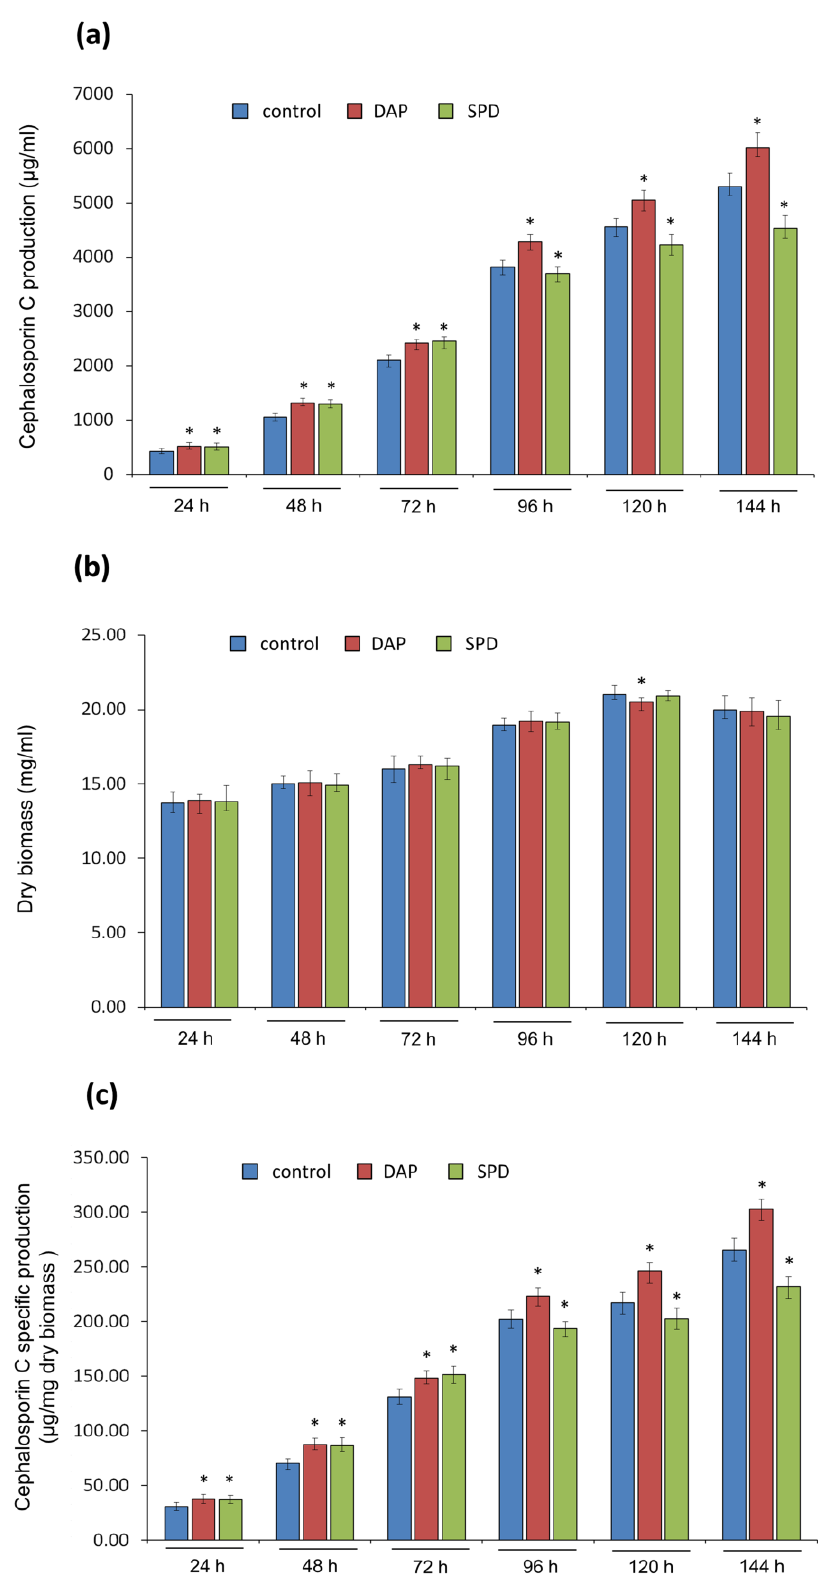
Figure 3. Effect of the addition of 5 mM 1,3-diaminopropane (DAP) or 5 mM spermidine (SPD) on cephalosporin C (CPC) production and growth of A. chrysogenum HY strain during fermentation on synthetic (SN) medium: ( a ) CPC production; ( b ) dry weight; ( c ) CPC specific production. Samples were taken at 24 h, 48 h, 72 h, 96 h, 120 h, and 144 h. Data are means ± SD, n = 3. Statistical significance, * p ≤ 0.05, as compared with the control (strain, cultivated on medium without PAs